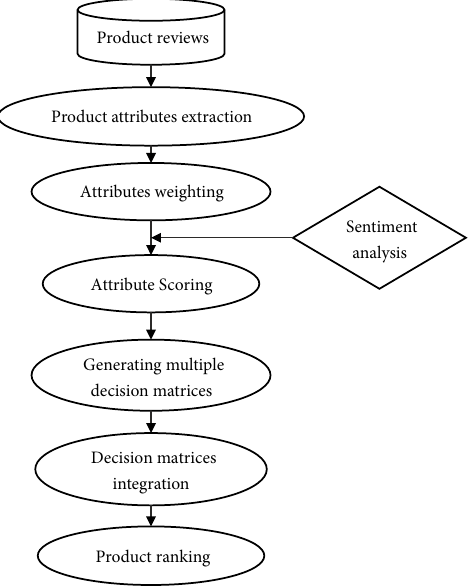
Figure 1. The process of the proposed